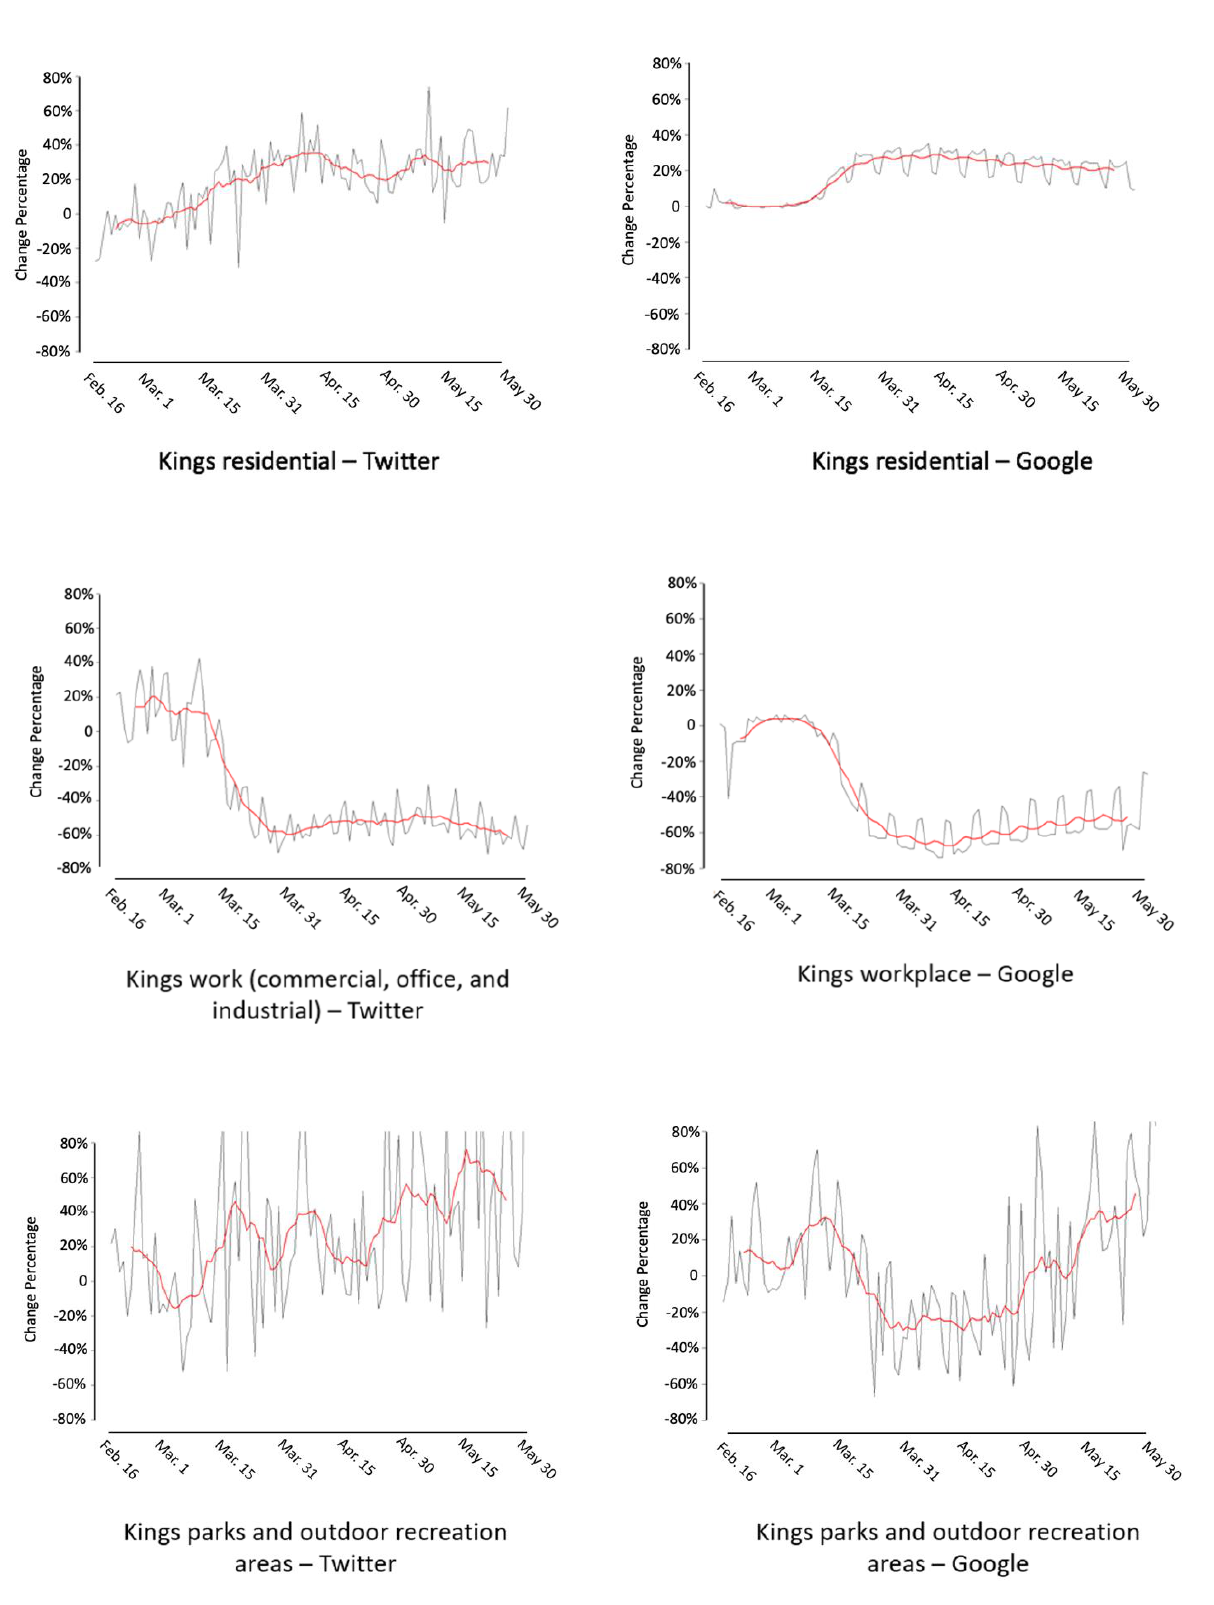
Figure 5. Twitter- and Google-based human mobility changing patterns in Kings County. We found a 20% increase in the number of Twitter users in Kings County for residen- tial areas, which is similar to Google Community Report. However, Twitter-based human mobility presents a larger day-to-day change, and this change is unstable. Google found that people spent about 20% more times in residential places, and weekly regularity is